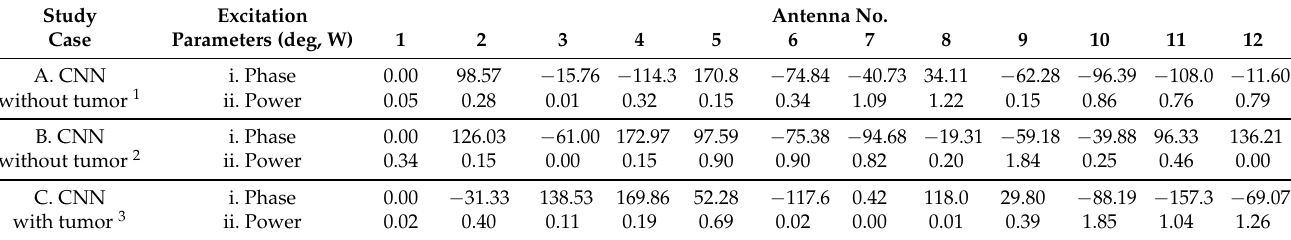
Table 2. Estimated circular antenna excitation